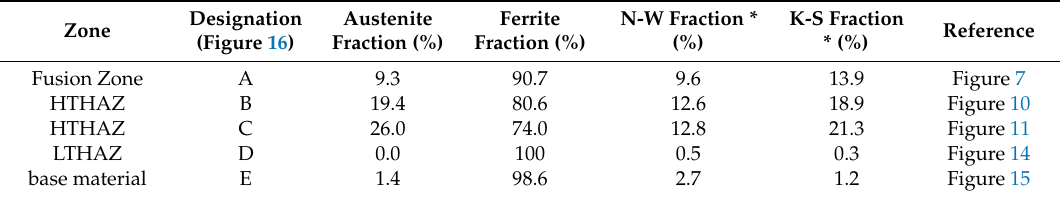
Table 5. Comparison of the phase fraction and the fraction of N-W and K-S orientations obtained by the EBSD analysis.